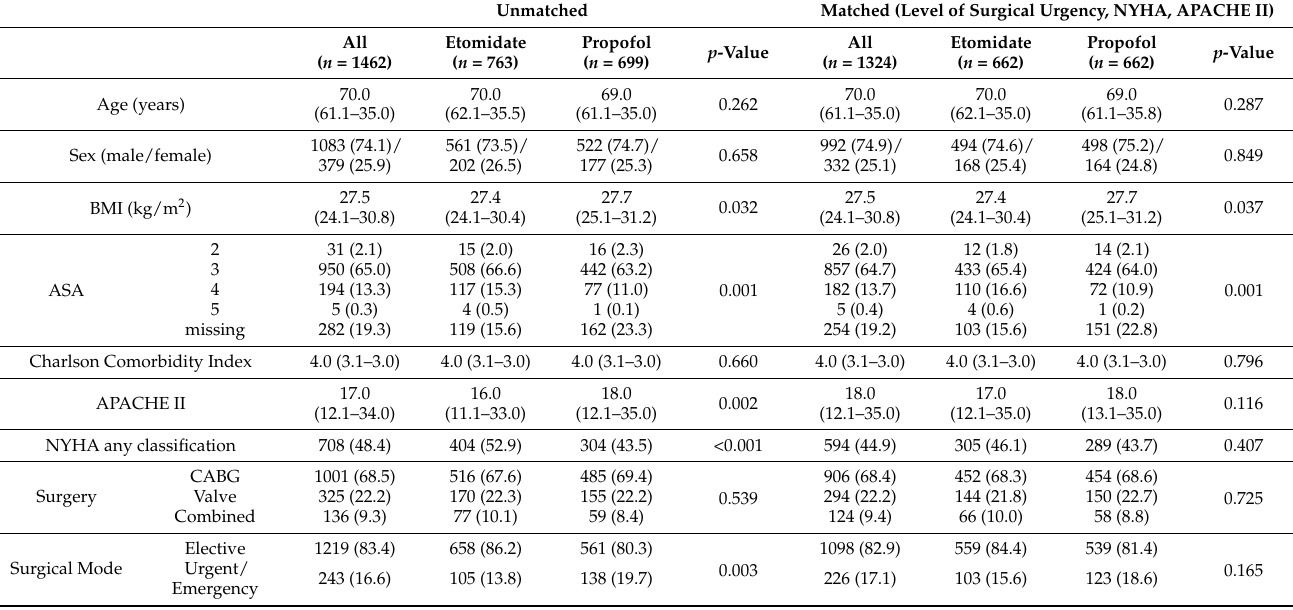
Table 1. Basic characteristics of matched and unmatched cohorts.